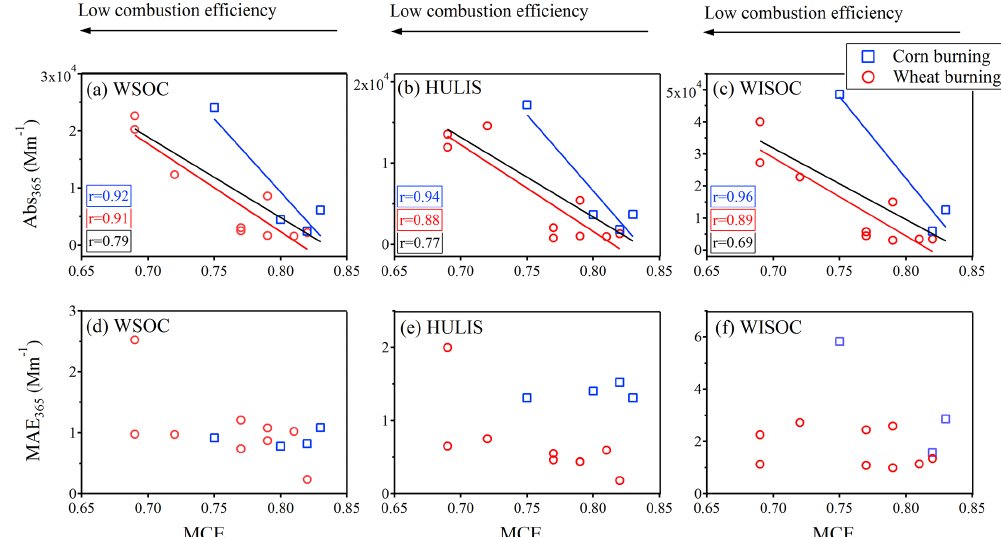
Figure 7. (a–c) Light absorption coefficients (Abs 365 ) and (d–f) mass absorption efficiency (MAE 365 ) of WSOC, HULIS C and WISOC at 365nm as a function of combustion efficiency. Corn and wheat burning emissions are denoted by red and blue colors, respectively. The r values in (a) – (c) are the correlation coefficients for corn (blue), wheat (red) and overall (black) burning